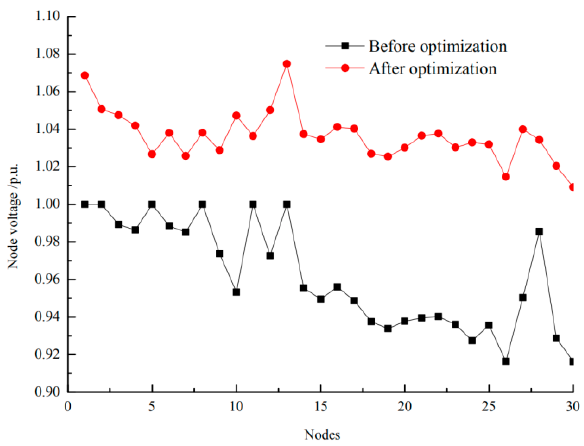
Figure 5. The bus voltage before and after optimization.